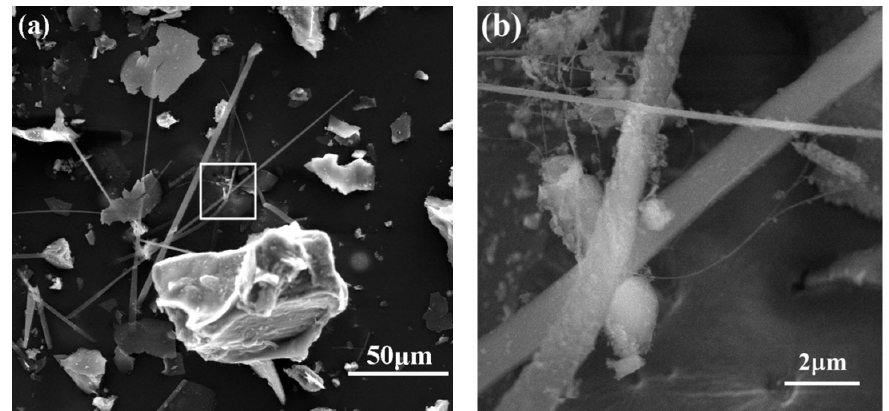
Figure 11. SEM images of samples B synthesized at 1550 °C (Si:C = 1:1): ( a ) Fibers and particles, ( b ) Enlarged view of selected area in (a).